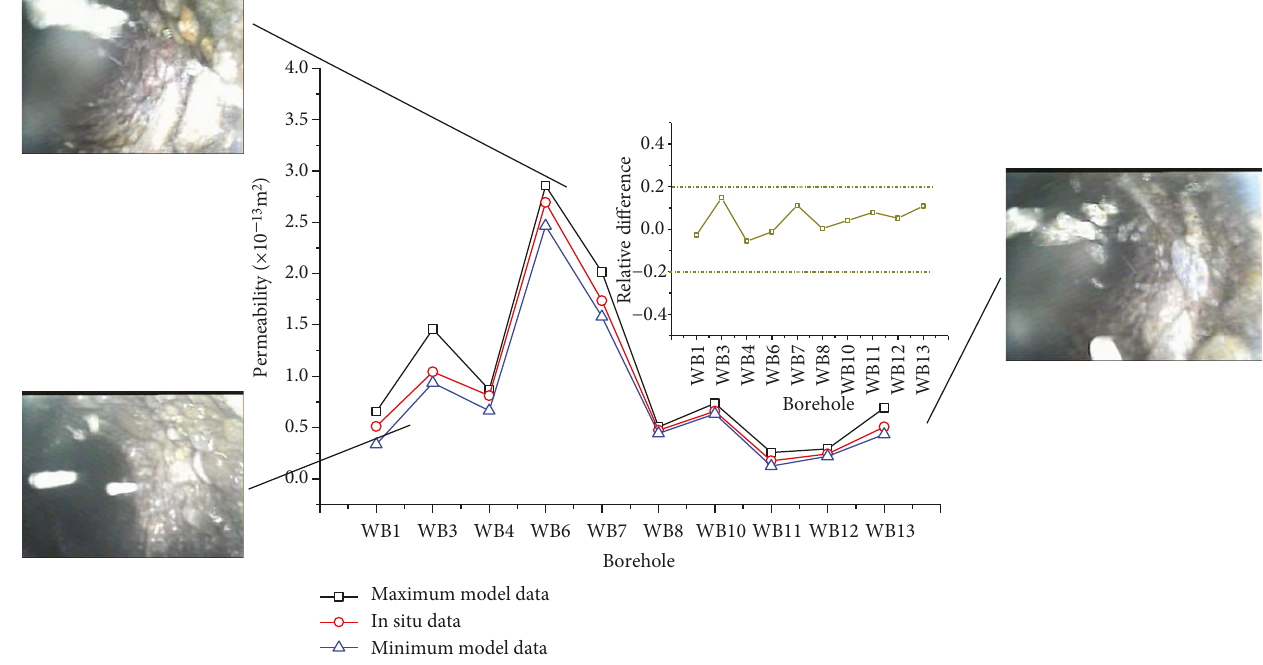
Figure 12: Comparison of model and in situ measure value of the permeability for conglomerate con fi ned